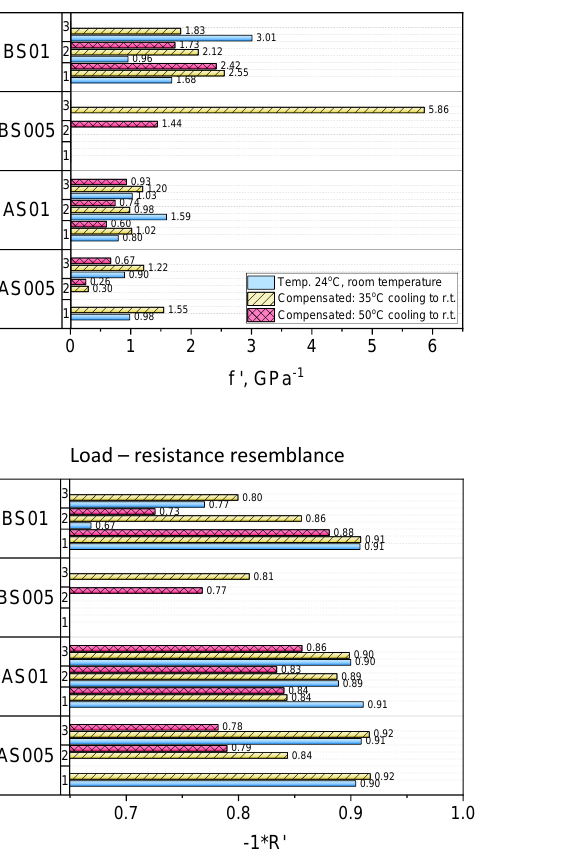
Figure 10. Comparison of stress-sensing factors f ′ and f ″ and cosine similarity ( R ′ and R ″ ) after compensating for the variations of impedance during the cooling down of the samples. Different patterns and colors are used for every preconditioning temperature.